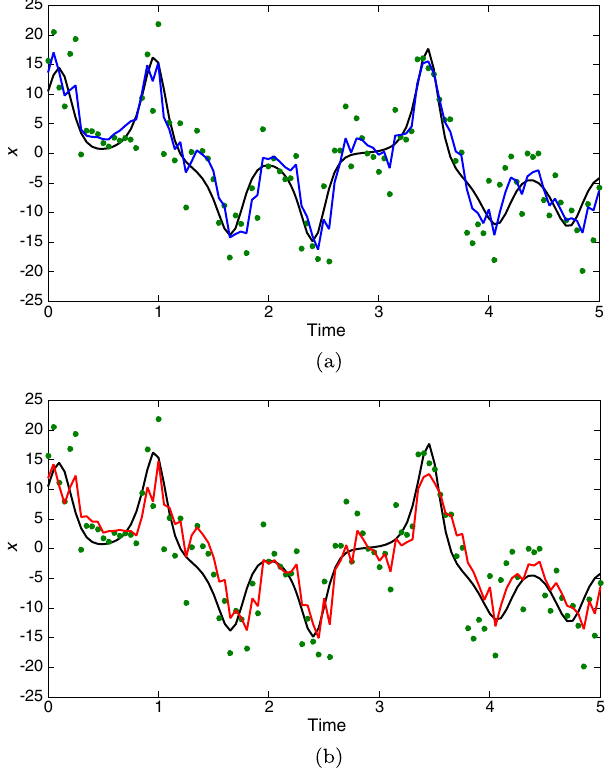
FIG. 2. Given noisy observations of the Lorenz-63 x variable (green circles) sampled at rate h ¼ 0 . 05 , the goal is to reduce the signal error (RMSE ¼ 4 . 76 ) using an ensemble Kalman filter where the true x trajectory (solid black curve) is desired. (a) If we have knowledge of the Lorenz-63 equations, the standard filtering methodology can be used whereby the noisy x data are assimi- lated to the model and using an EnKF a noise-reduced estimate of the x variable as well as estimates of the unobserved y and z variables are provided. We refer to this as the parametric filter (solid blue curve, RMSE ¼ 2 . 87 ). (b) The Kalman-Takens filter is able to significantly filter the noise in the observed signal (solid red curve, RMSE ¼ 3 . 04 ) to a level comparable to the parametric